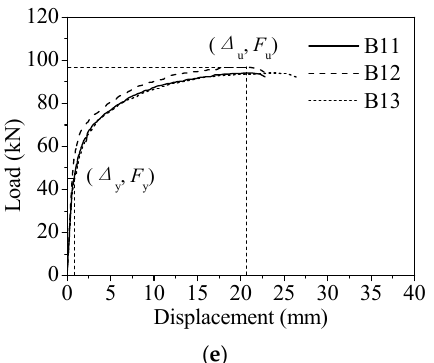
Figure 6. Load-displacement curves of specimens. ( a ) Group A1; ( b ) Group A2; ( c ) Group A3; ( d ) Group A4; ( e ) Group B1.